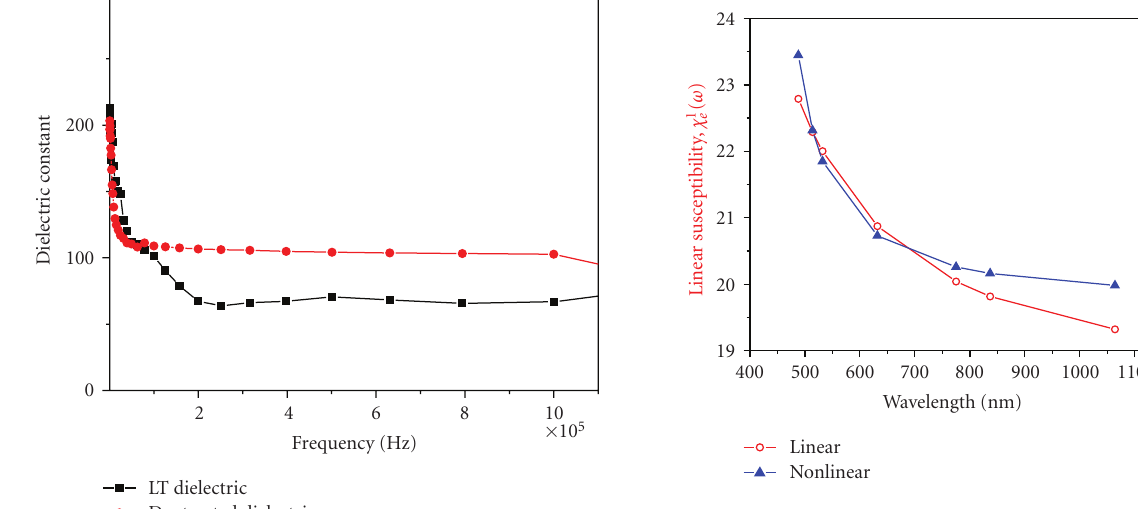
Figure 35: Dispersion of Linear and Nonlinear (SHG) susceptibility with wavelength for L-threonine single